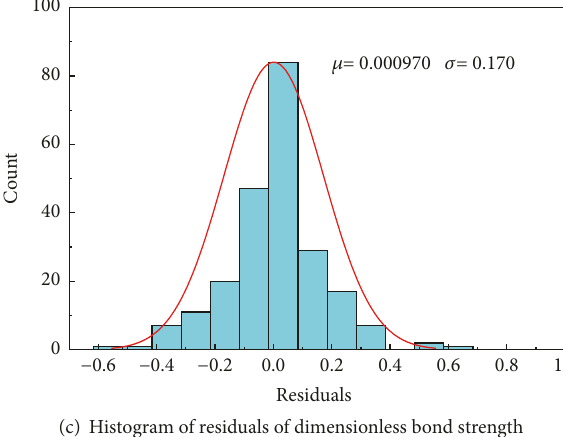
Figure 7: Dimensionless bond strength of beam-end specimens: (a) dimensionless bond strength versus corrosion level; (b) residuals versus corrosion level; (c) histogram of residuals of dimensionless bond